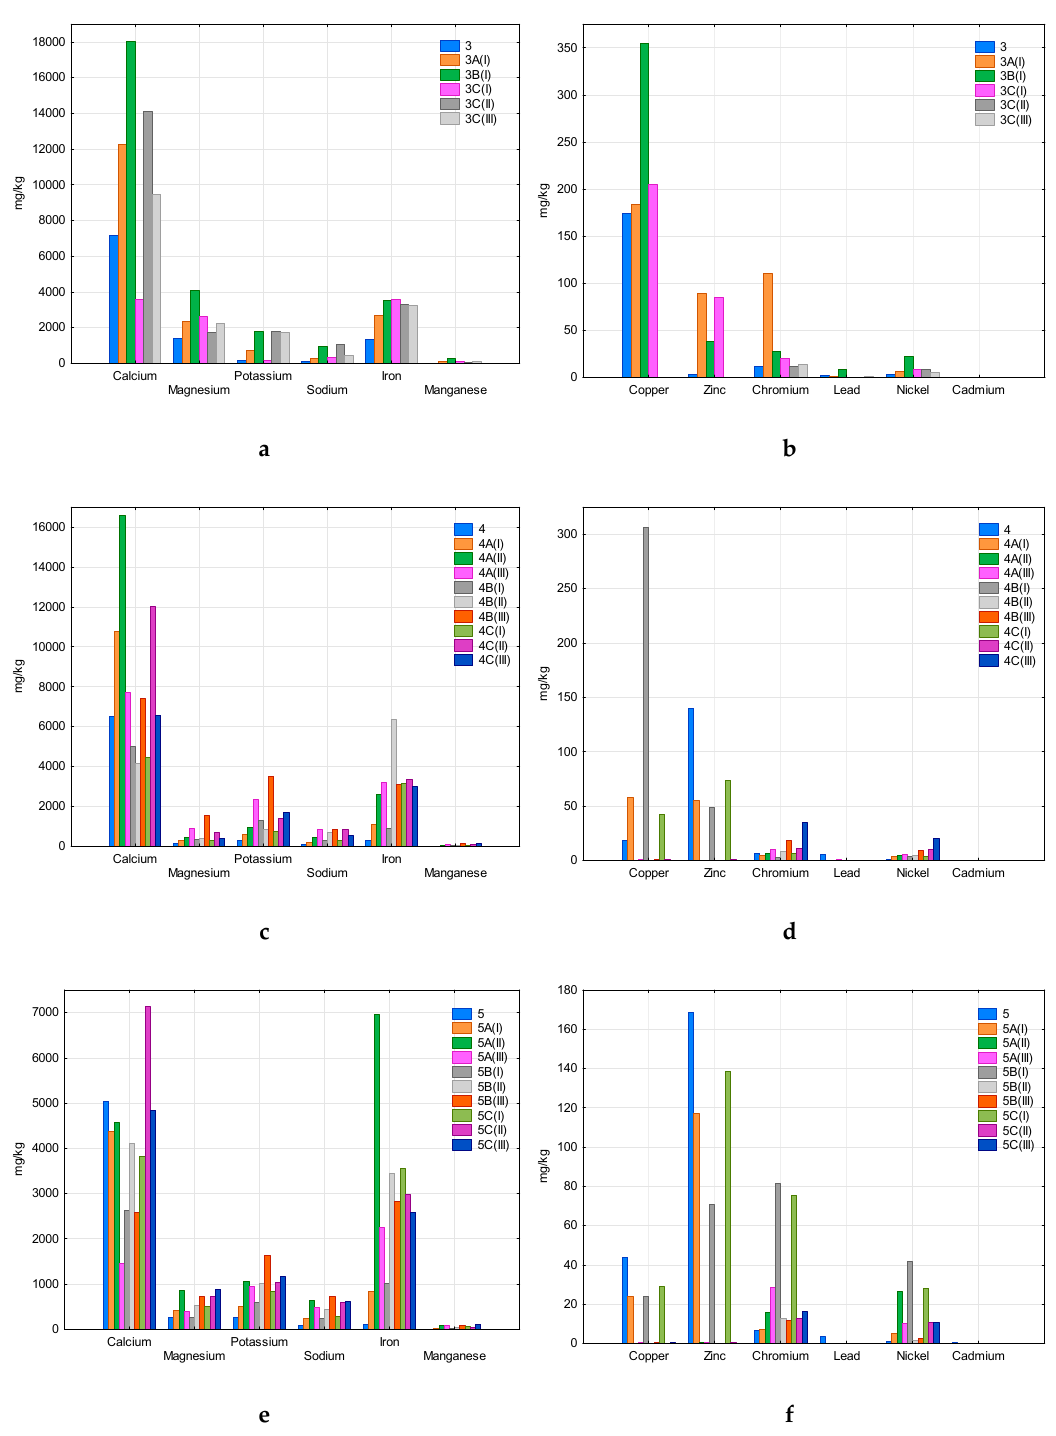
Figure 3. Comparison of the content of analysed metals in new and composted samples 3 ( a —macroelements, b —heavy metals), 4 ( c —macroelements, d —heavy metals), and 5 ( e —macroelements, f —heavy metals).